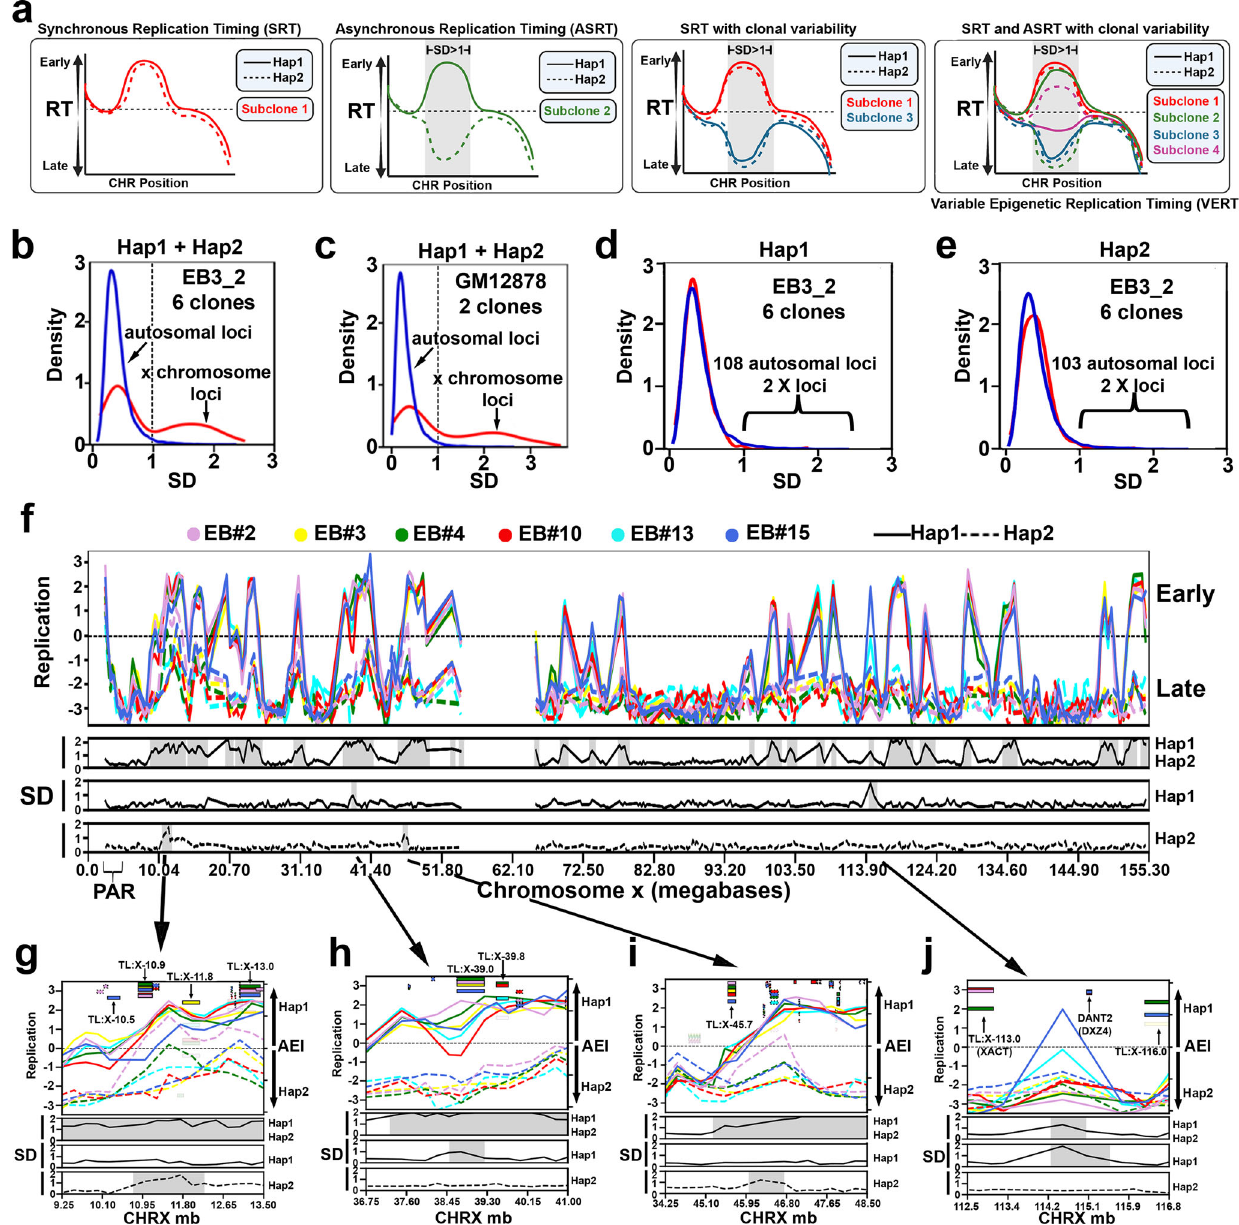
Fig. 3 | Haplotype resolved analysis of asynchronous replication timing. a Illustrationofahypotheticalgenomicregionwithsynchronousreplicationtiming (SRT), asynchronous replication timing (ASRT), and possible clonal variability in bothSRTandASRT.Outliersinthestandarddeviation(SD)arehighlightedingray. b , c Genome-wide distribution of the SD of the combined RT of individual alleles amongclonesderivedfromEB3_2(12alleles)andGM12878(4alleles). d , e Genome- wide distribution of the SD of the allele restricted replication timing of each indi- vidual alleleamong clones derived from EB3_2 ( d : 6 Hap1 alleles; e : 6 Hap2 alleles). Outlierswere identi fi ed as: SD ≥ 2.5xSD+mean:>0.96for Hap 1 and >0.98 forHap 2 in the EB3_2 clones and >0.92 for Hap 1 and >0.94 for Hap 2 in the GM12878 clones. f Chromosome X Early/Late RT pro fi le with SD of haplotype-resolved replication timing from the 6 EB3_2 clones highlighting (gray shading) outlier regions from the “ combined RT pro fi le ” (Hap1 plus Hap2) and from the “ allele-